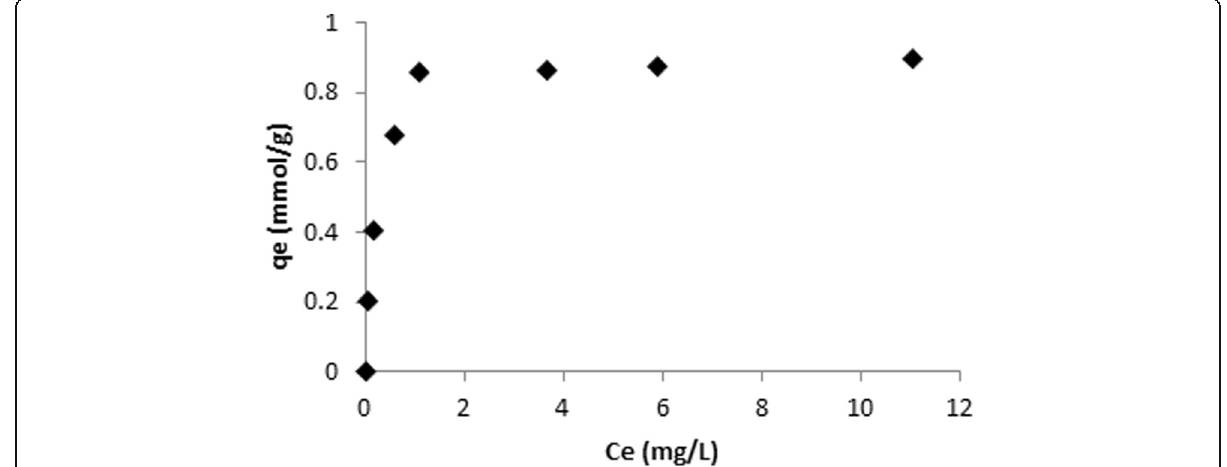
Fig. 9 Adsorption isotherms of Cr (VI) adsorbed by N6,6/GO (equilibrium time: 6 h, dosage: 2 g/L, pH = 2.0, temperature: 25 °C)